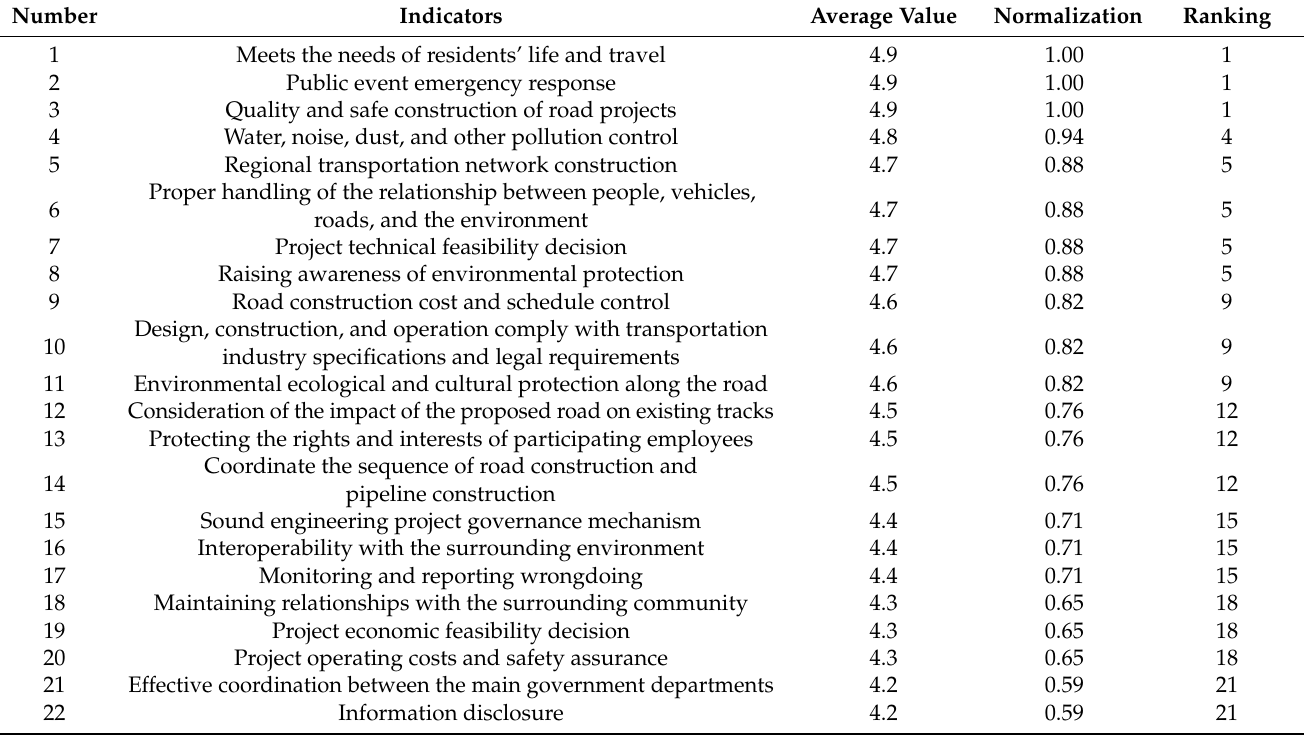
Table 2. Ranking of MMRISR